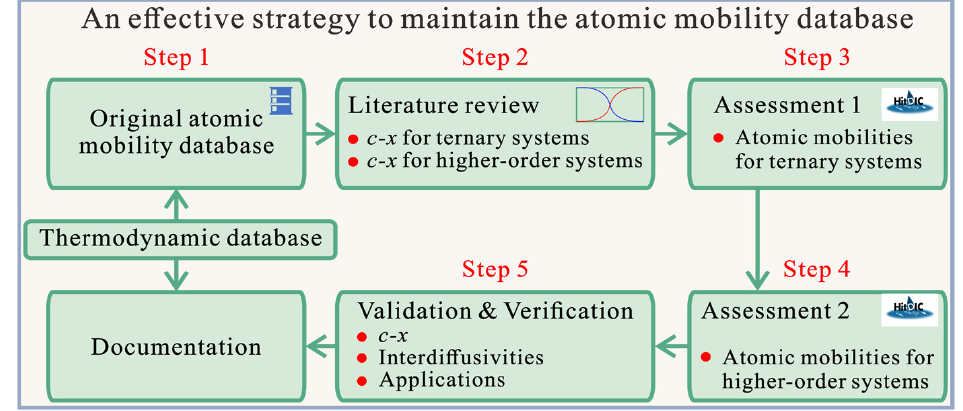
Figure 1. An effective strategy for maintaining the atomic mobility database of multicomponent systems proposed in this work. Here, the “ c–x ” represents the “composition–distance”.